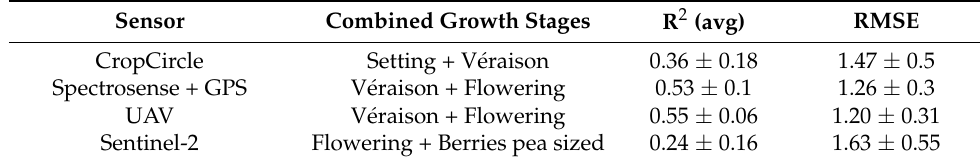
Table 6. Given a specific sensor, the best combination of growth stages and the corresponding best R2 over the two growing seasons (2019 and 2020), using AutoML to assess their performance in evaluating grape quality attributes (legend as for Table 2).